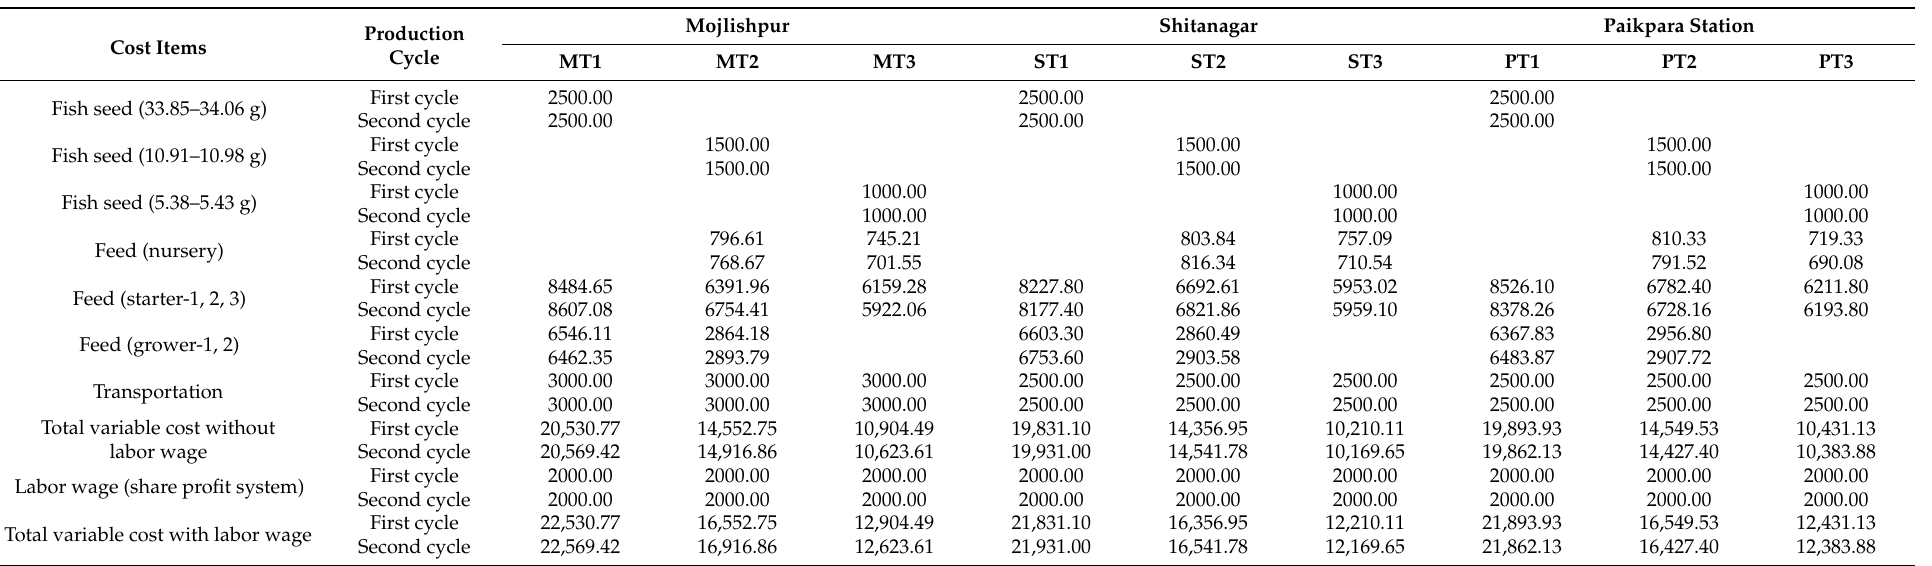
Table 6. Variable cost (BDT) of Nile Tilapia ( O. niloticus L.) culture for 120 days under cage-culture